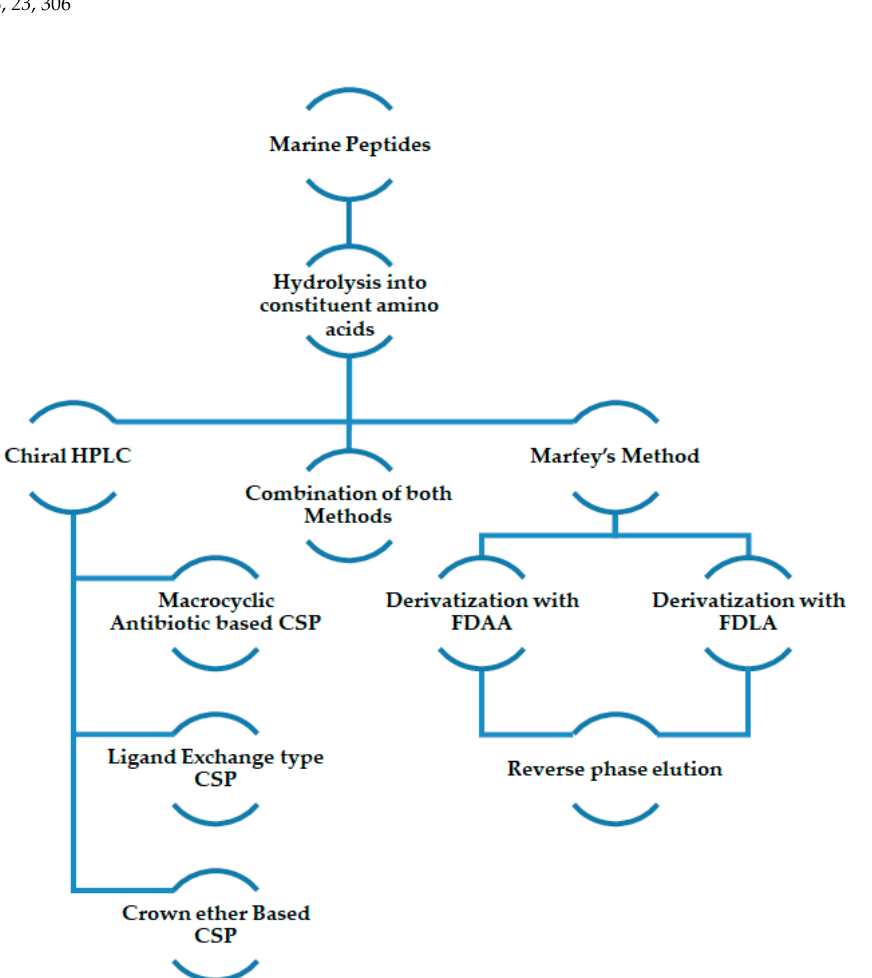
Figure 1. Schematic presentation of the methodologies generally used for determination of the configuration of amino acid residues of marine peptides. HPLC—High Performance Liquid Chromatography; CSP—Chiral Stationary Phase; FDAA—1-Fluoro-2-4-dinitrophenyl-5- D , L -alanine amide; FDLA—1-Fluoro-2-4-dinitrophenyl-5- D , L -leucine amide.